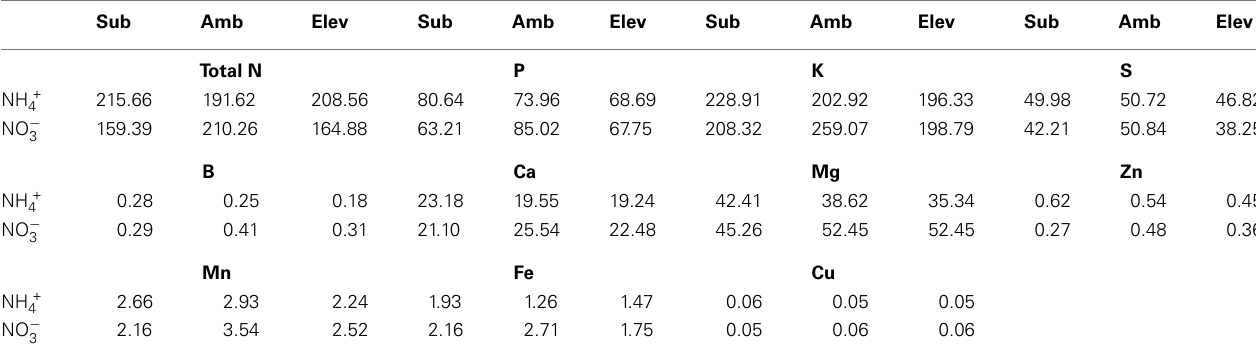
Table 2 |Total plant nutrients (mgplant − 1 ) as affected by N form and CO 2